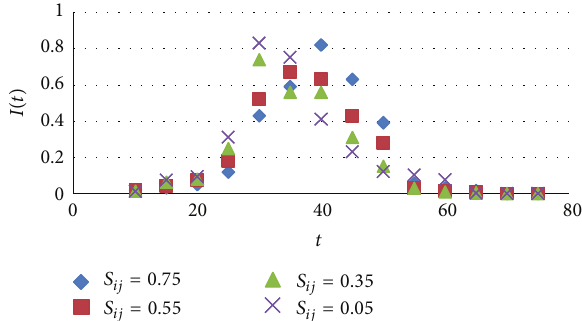
Figure 4: Relationship strength between nodes impact on informa- tion